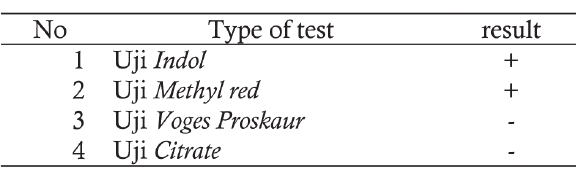
Results of biochemical test on the samples of uropathogenic E.